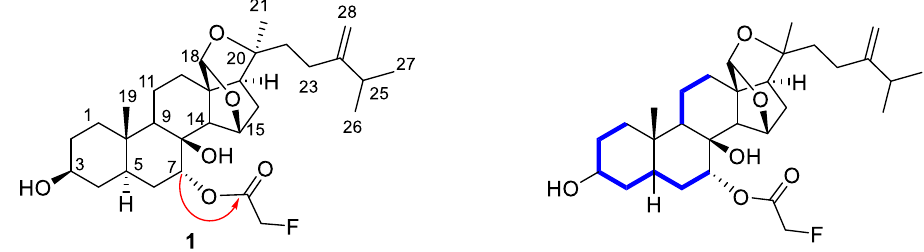
Figure 4. Key HMBC (red arrow) and TOCSY (blue line) correlations observed in compound 7 .